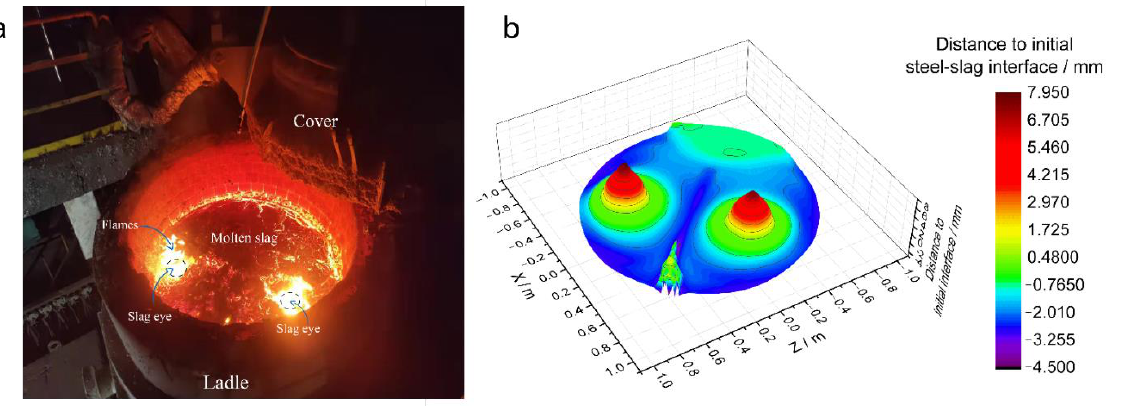
Figure 13. ( a ) The molten steel and slag surface during the argon-stirred process, and ( b ) the numerical simulation results of the steel – slag interface position.